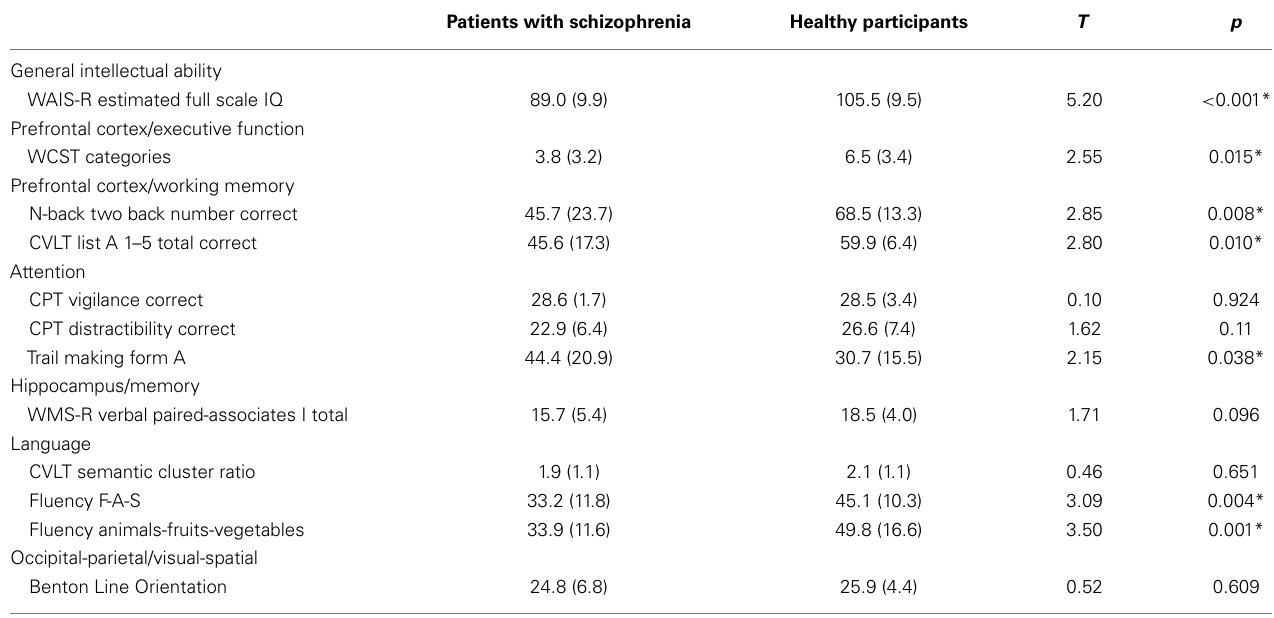
Table 2 | Means and standard deviations (in parentheses) for additional cognitive tests in patients with schizophrenia and healthy